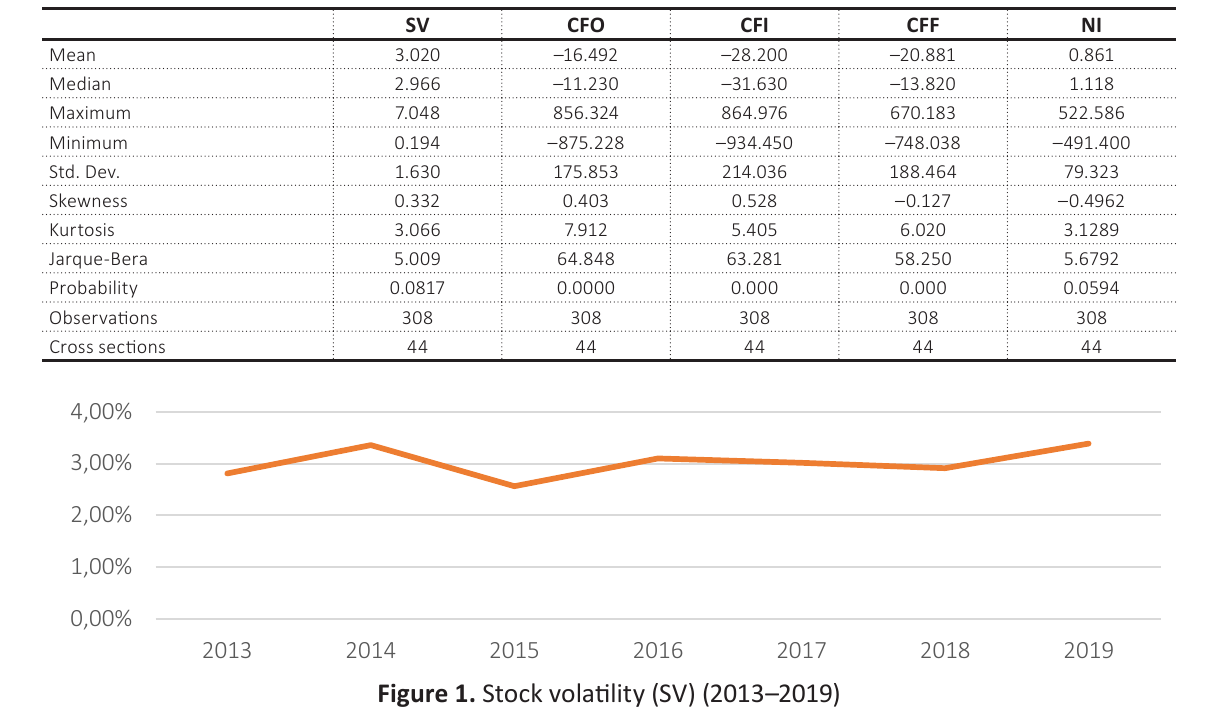
Table 2. Descriptive statistics of the study variables